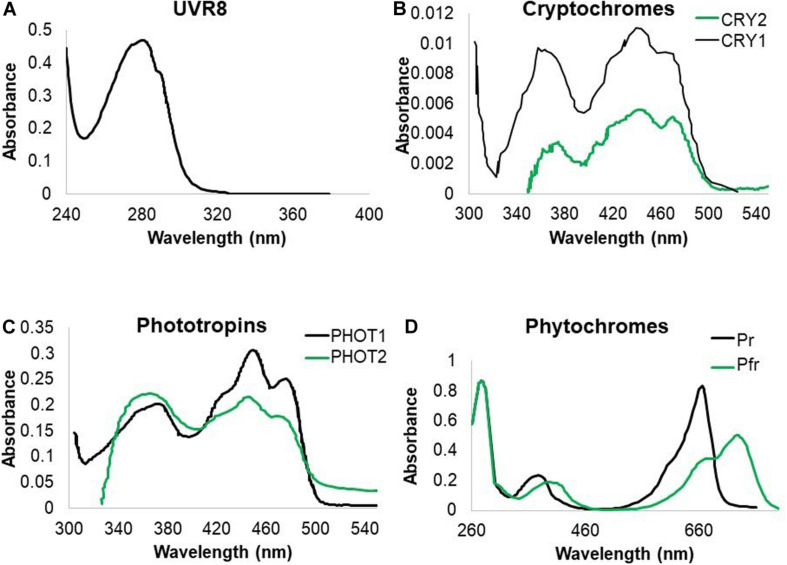
Absorption spectra of UV-B absorbing photoreceptors in Arabidopsis. (A) UVR8 absorption is recorded in the UV-C and UV-B region of the spectrum. (B) CRY1 and CRY2 absorb both strongly in blue and UV-A radiation with indication that CRY1 strongly absorbs in the UV-B band. (C) PHOT1 and PHOT2 both absorb mainly in the blue and UV-A wavelengths of the spectrum with indications that PHOT1 also absorbs UV-B. (D) PHY proteins have an absorption peak in red and far red wavelengths but also absorb UV-A and UV-B (Ahmad et al., 2002; Kasahara et al., 2002; Sang et al., 2005; Christie et al., 2012).